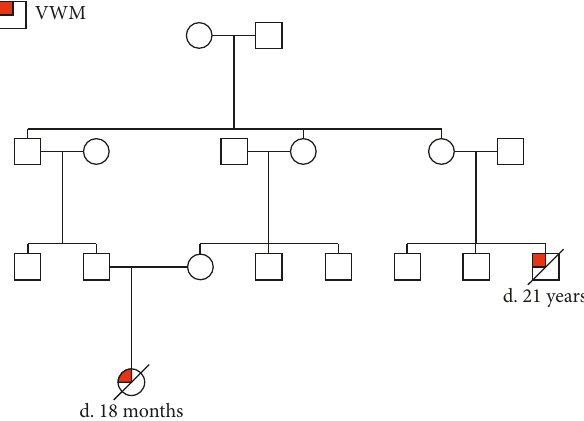
Figure 1: Pedigree chart of the proband with affected family members.